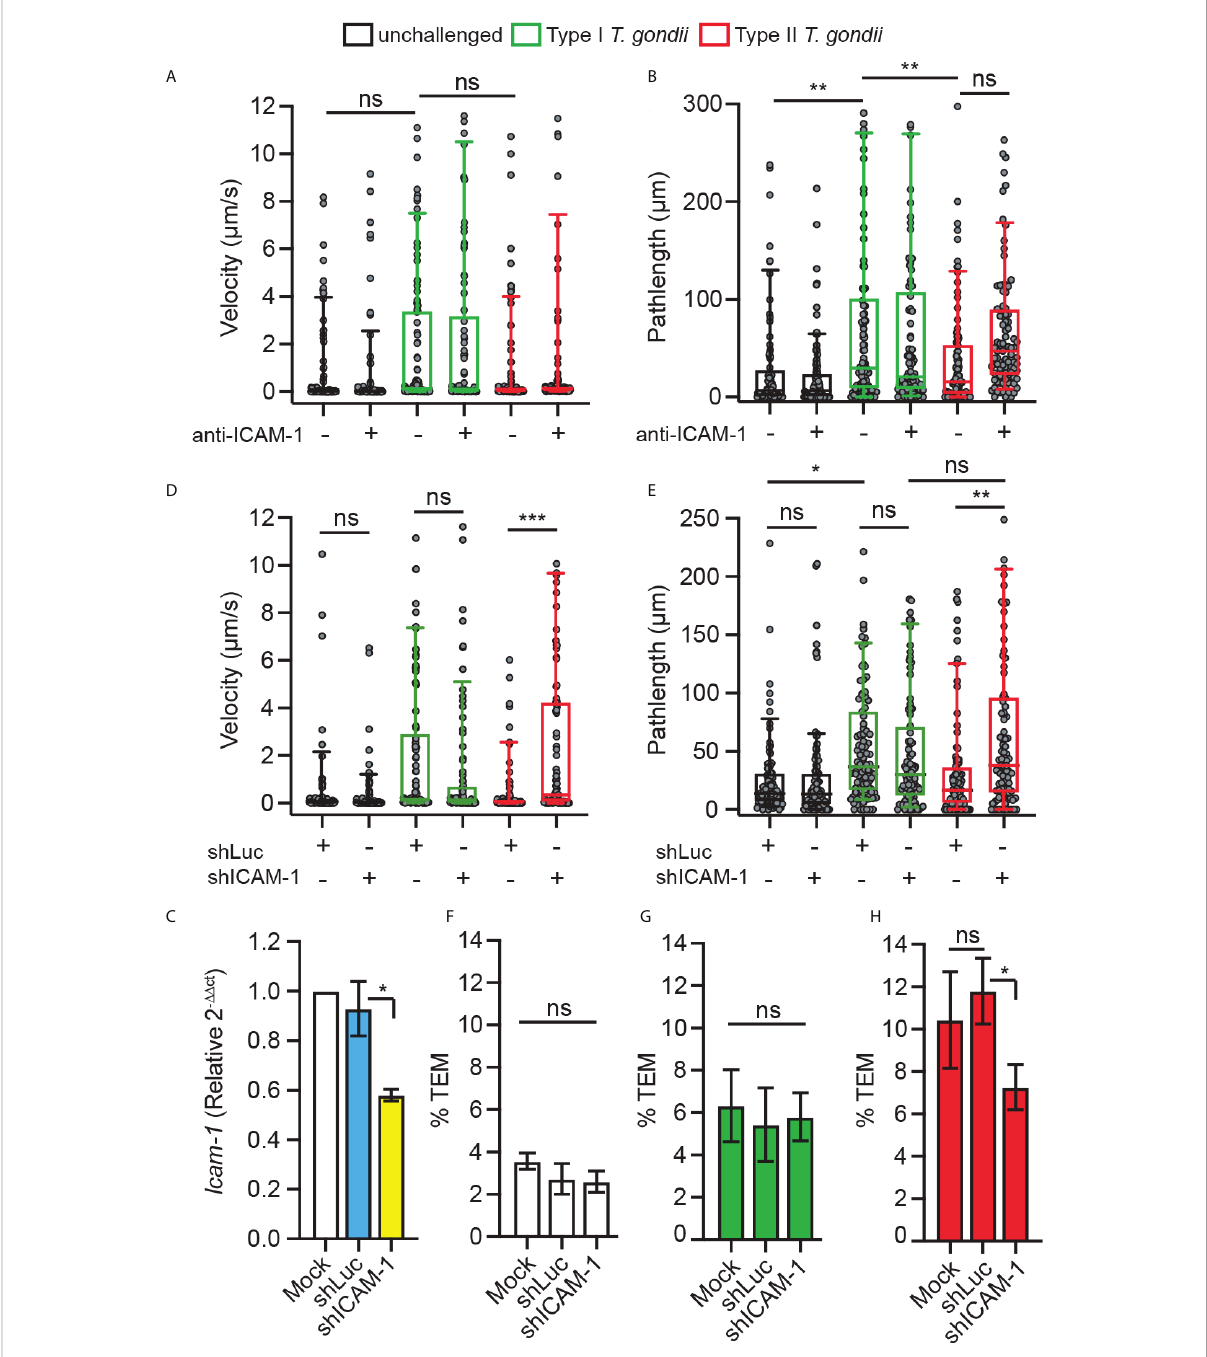
FIGURE 3 Implication of DC ICAM-1 in motility and TEM. (A, B) Box-and-whisker and scattered dot plots represent median velocities ( m m/s) and pathlengths ( m m), respectively, of type I (RH) or type II (ME49)-challenged DCs on bEnd.3 ± antibodies. Grey circles represent velocities or pathlengths, respectively, from individual cells. 95-100 cells were tracked per condition, from 3 independent experiments. (C) Icam-1 mRNA expression (2 - DD Ct ) in DCs transduced with shICAM-1 or control shLuc lentivirus relative to mock-treated cells (mock set to 1.0). (D, E) Box-and- whisker and scattered dot plots represent median velocities ( m m/s) and pathlengths ( m m), respectively, of mock-treated DCs and DCs transduced with lentiviral vectors targeting Icam-1 mRNA (shICAM-1) or a non-expressed target (shLuc) challenged with type I (RH) or II (ME49) T. gondii on bEnd.3. Grey circles represent velocities or pathlengths, respectively, from individual cells. 95-100 cells were tracked per condition, from 3 independent experiments. (F – H) TEM frequencies of unchallenged DCs (F) , type I (RH)-challenged DCs (G) and type II (ME49)- challenged DCs (H) across bEnd.3 cell monolayers shown as percentage (%) of DCs added in the upper well. Bar graphs represent the mean ± s.e.m of 3-4 independent experiments. * P < 0.05, ** P < 0.01, *** P < 0.001, ns: non-signi fi cant, by one-way ANOVA, Sidak ’ s post-hoc